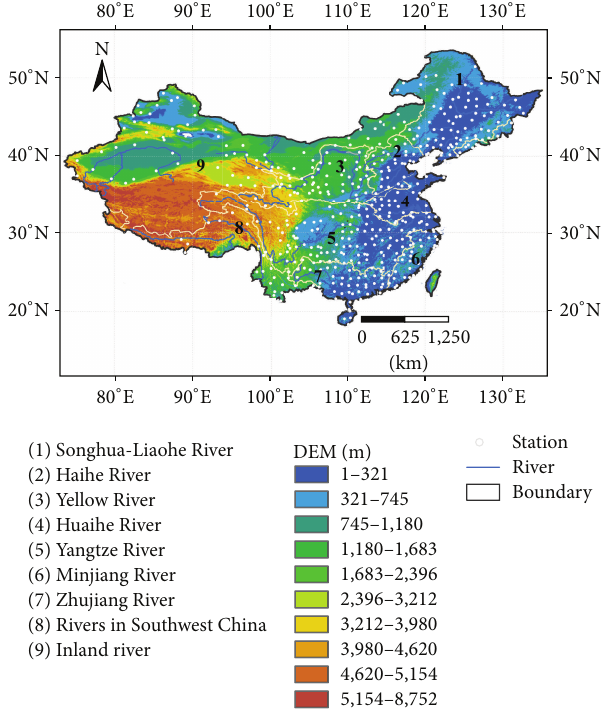
Figure 1: Locations of 483 rain gauge stations of